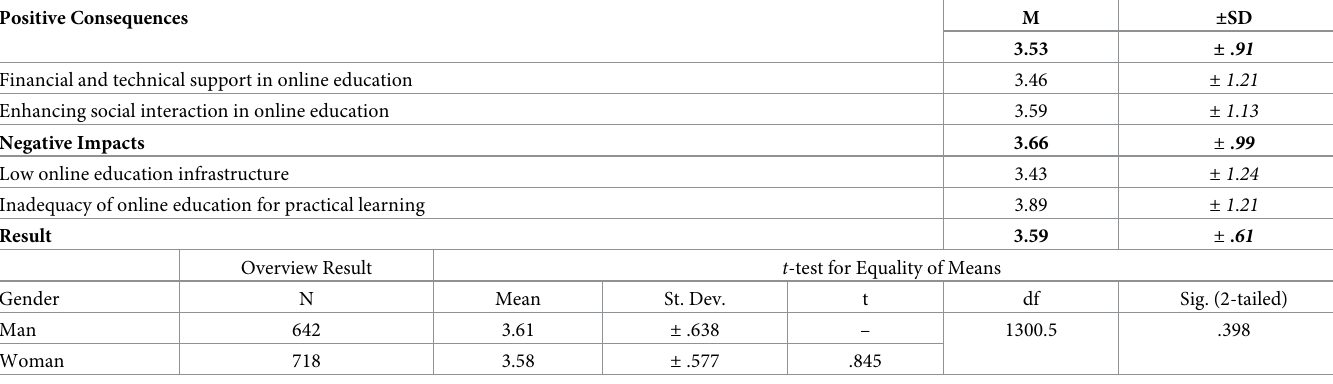
Table 8. Descriptive statistics for the impacts of COVID-19 on online education aspect of students’ lives. Positive